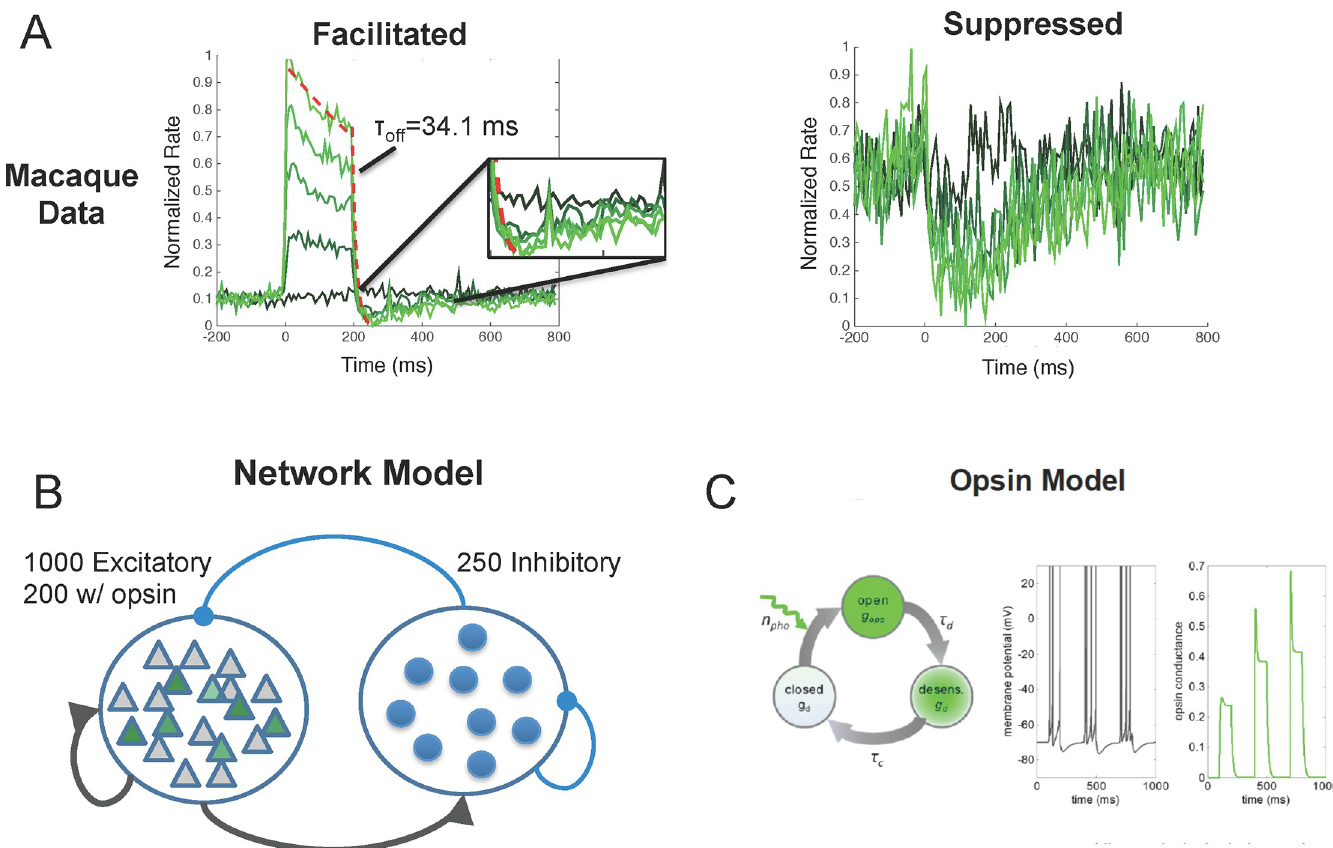
Fig 1. Recorded data from macaque V1 and model details. A) During laser stimulation, facilitated neurons had a fast onset response followed by a transient to sustained response profile similar to that seen following visual stimulus presentation. Immediately following laser offset, facilitated neurons in macaque V1 were quickly suppressed beyond their baseline firing rate for > 100ms (left). The temporal response profile of suppressed neurons (right) reached peak suppression at ~100 ms after stimulation. After laser offset, the modeled and recorded neurons remained suppressed for ~200 ms and slowly returned to baseline. B) The modeled network is a recurrent neural network of 1000 excitatory and 250 inhibitory neurons and contains excitatory-excitatory, excitatory-inhibitory, inhibitory-excitatory, and inhibitory- inhibitory connections. Of the excitatory neurons, 200 contained the modeled opsin. C) The opsin conductance was modeled using a 3-state model, which includes an open, desensitized, and closed state. Increasing the number of photons (simulating different light levels) opens conductance channels (transient state) after which they become desensitized (sustained stated). When the light is turned off, conductance channels move to a closed state and the conductance decays to zero (left). A single simulated neuron and opsin conductance (right). As the opsin conductance increases, it drives the cell to fire at higher